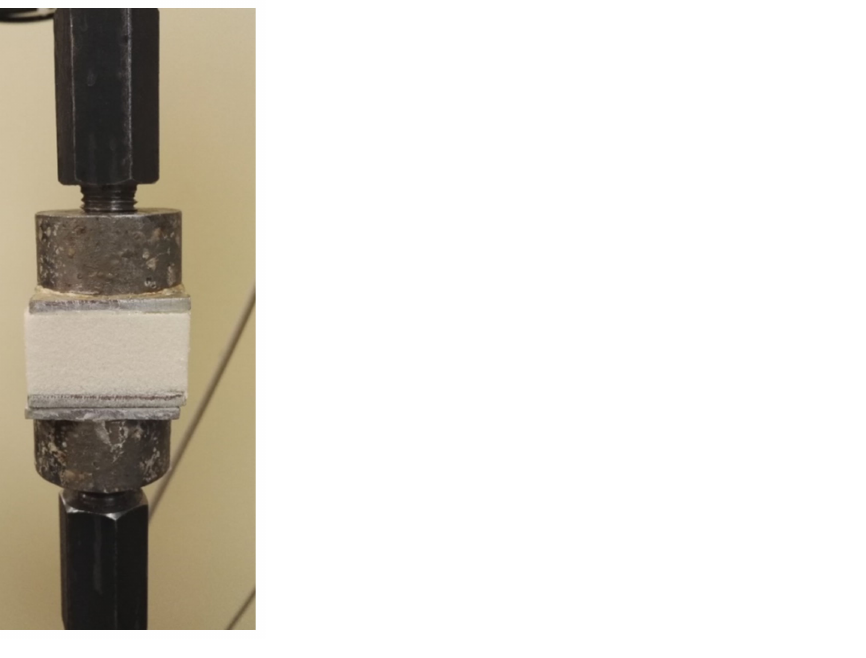
Figure 3. Cryogenic insulation rigid PU foam sample prepared for adhesion